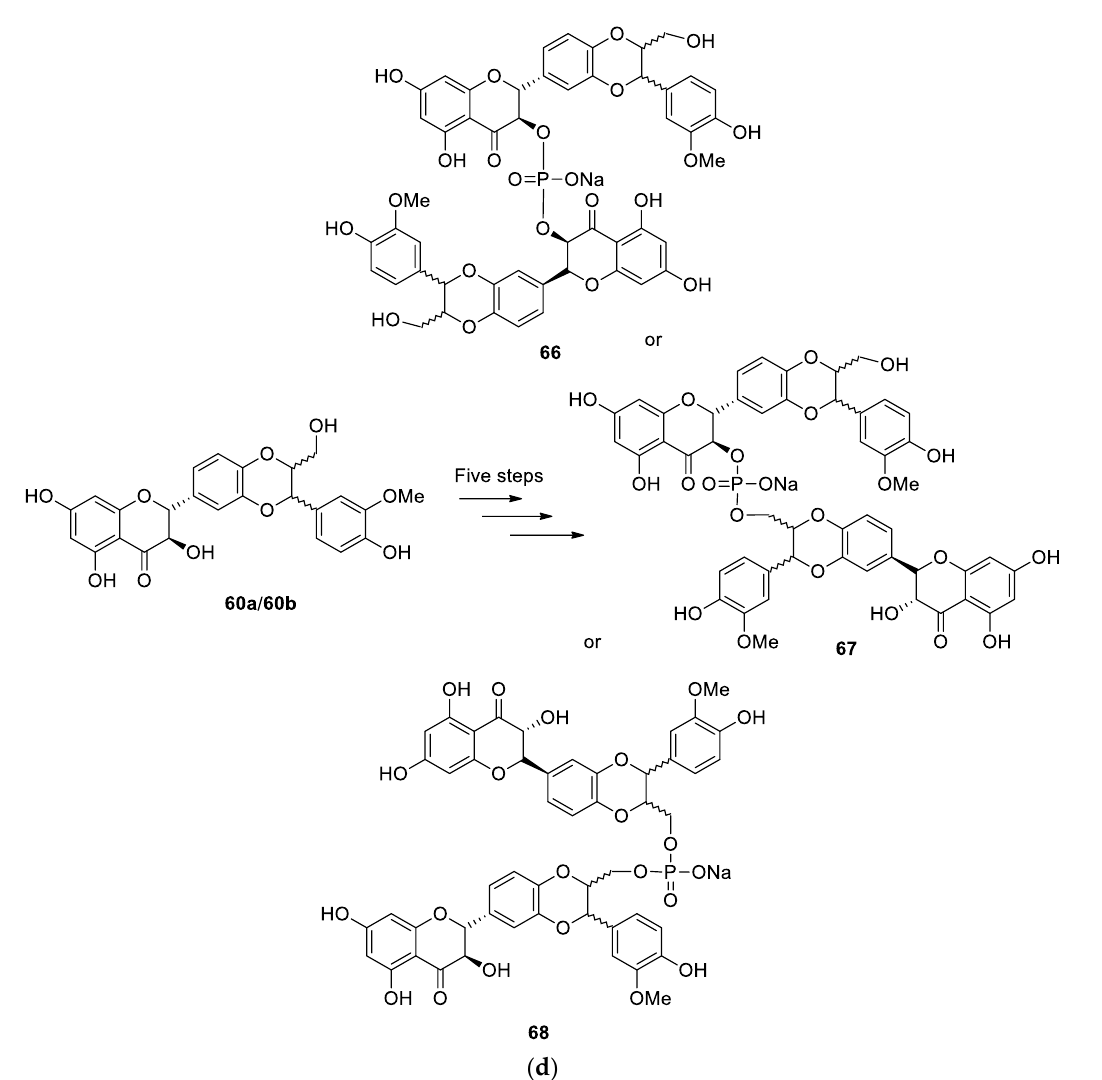
Figure 14. ( a ) Structure of silybin 60a and 60b , of 2,3-dehydrosilybin 61 and their dimers. ( b ) Silybin A and B dimers ( 62 ) with different combination linked at C-7 by a diether spacers. ( c ) Synthesis of symmetric flanovolignan dimers 64aa , 64bb, and 65 via oxidative coupling involving laccase from Trametes versicolor . ( d ) Synthesis of phosphate-linked silybin dimers 66 – 68 synthesized from silybin A/B 60a/60b .